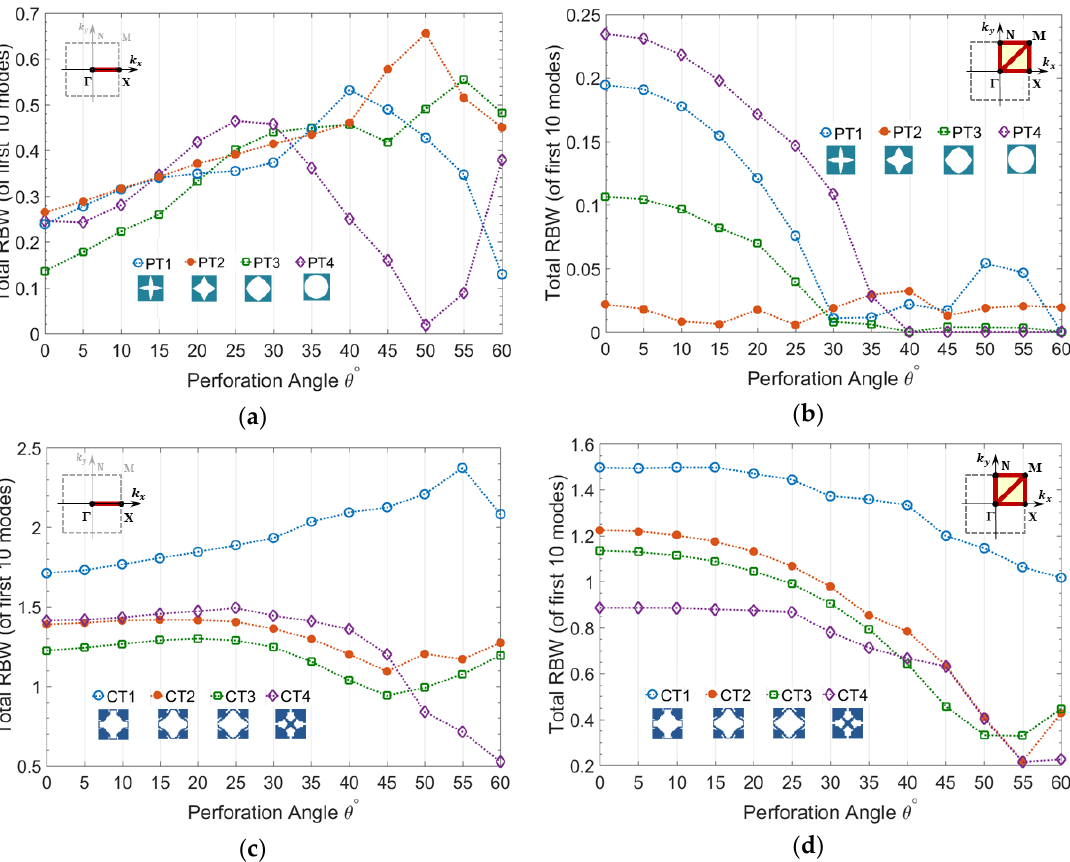
Figure 3 . Total relative bandgap width (RBW) of mixed guided wave modes versus perforation angle calculated for ( a , b ) prescribed topologies PT1-PT4 and ( c , d ) optimized topologies CT1-CT4, ( a , c ) partial bandgap in ΓΧ and ( b , d ) complete bandgap in ΓΧΜΓΝΜ